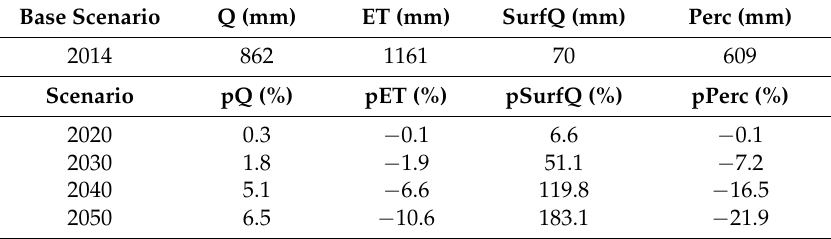
Table 4. Percent difference between annual average water balance components simulated for 2020, 2030, 2040, and 2050 and simulated in the baseline